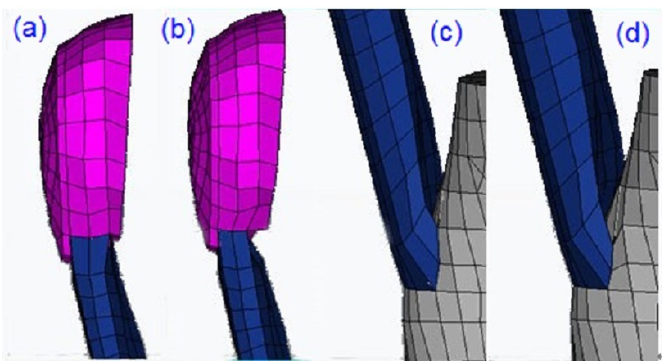
Figure 3. The finite element model of patellar tendon: ( a ) the upper before release; ( b ) the upper 81 released; ( c ) the lower before release; ( d ) the lower released. 82